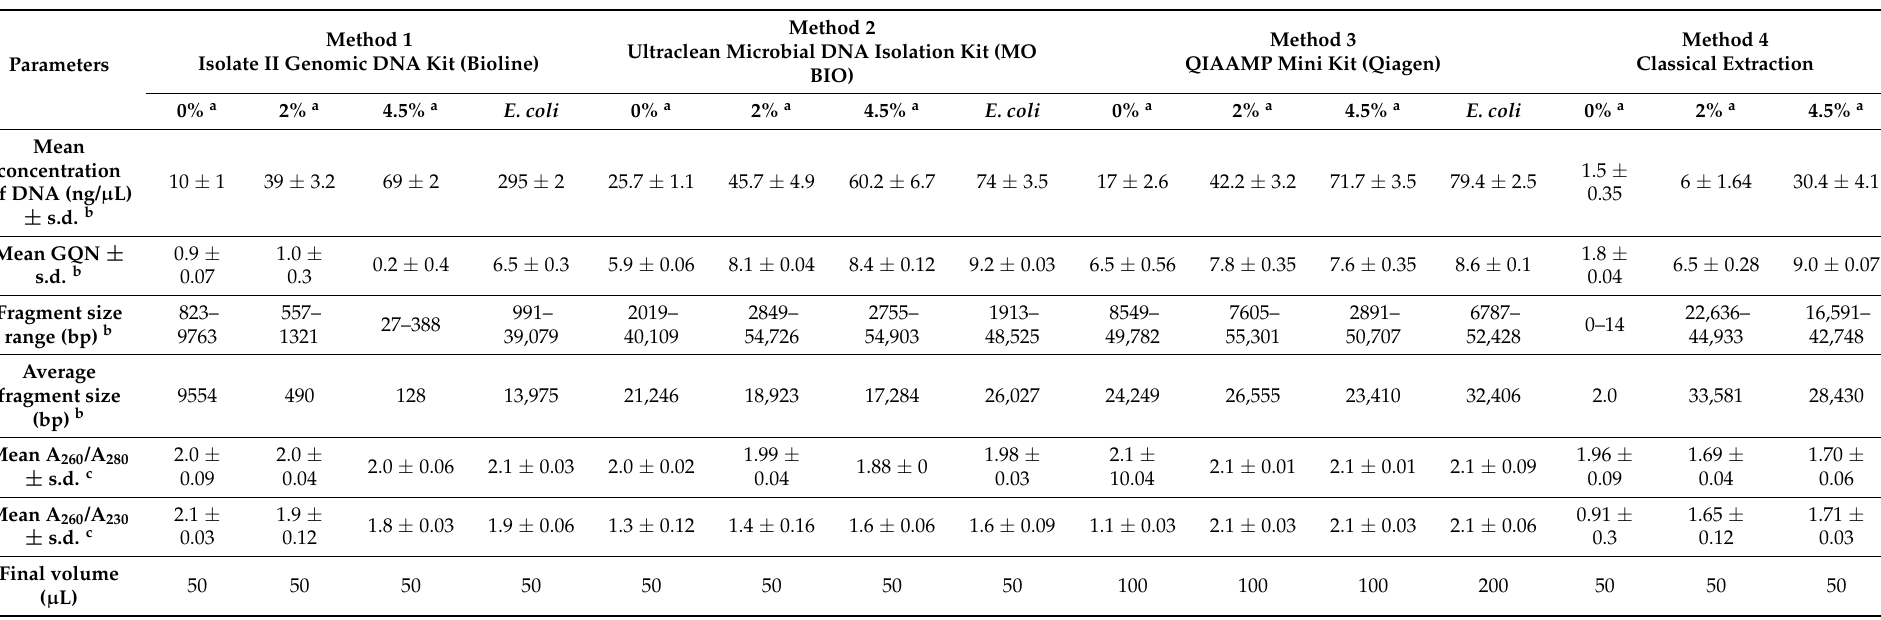
Table 1. Average scores for DNA quality and quantity following extraction from Williamsia sp. 1138 cells cultured in MSM supplemented with 0, 2 and 4.5%